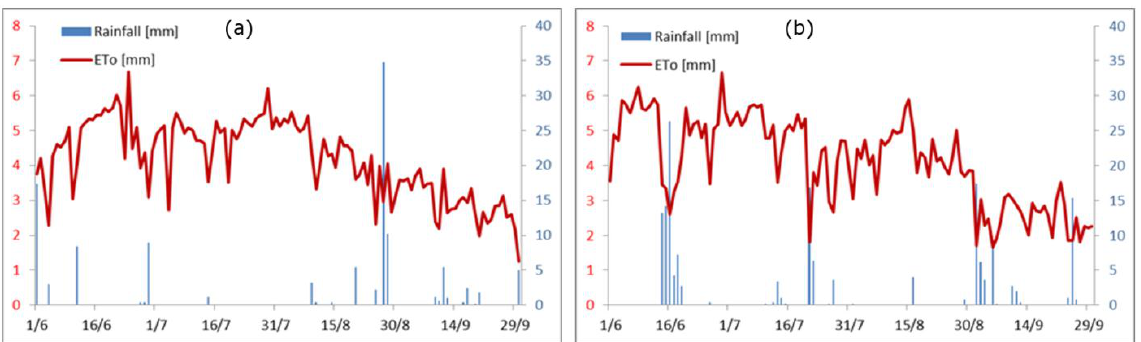
Figure 4. Seasonal trends of temperature and rainfall at an agrometeorological station in Andria for the years 2013 ( a ) and 2014 ( b ).